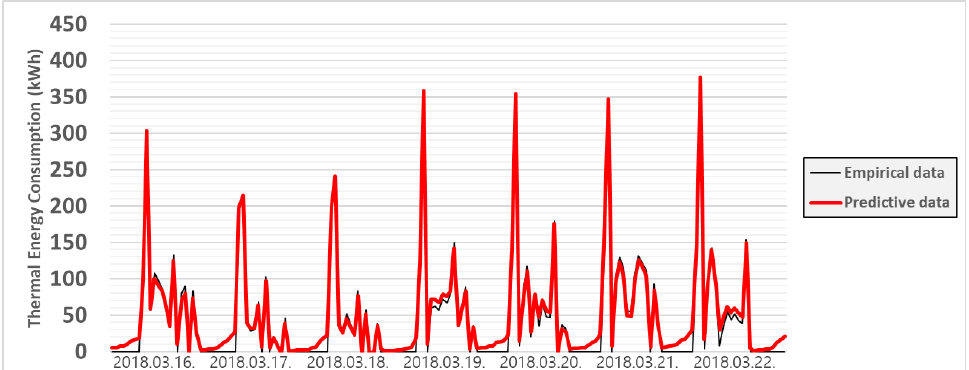
Figure 11. Case 2: Comparison between empirical and predictive data.